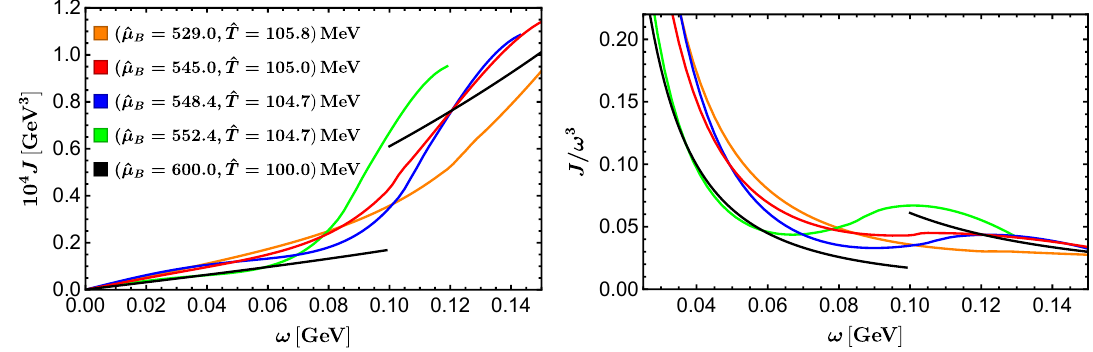
Figure 5 . The angular momentum J (left) and the dimensionless combination J/ω 3 (right) as a function of ω . The ω dependence of J/ω 3 develops a peak structure as approaching a CEP from the crossover region. We have taken ‘ = 1 GeV − 1